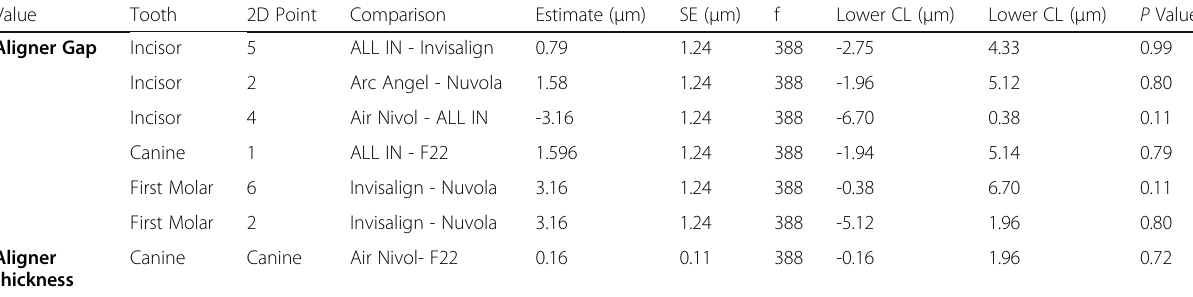
Table 6 Comparisons of gap and aligner thickness of investigated systems that do not reach statistical significance ( P < 0.05*) Value Tooth 2D